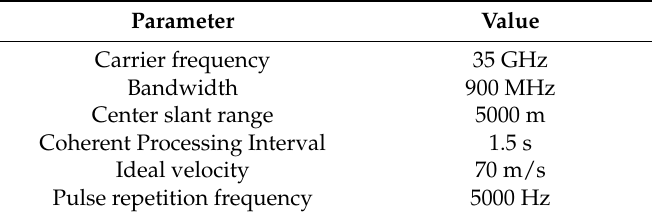
Table 1. SAR System